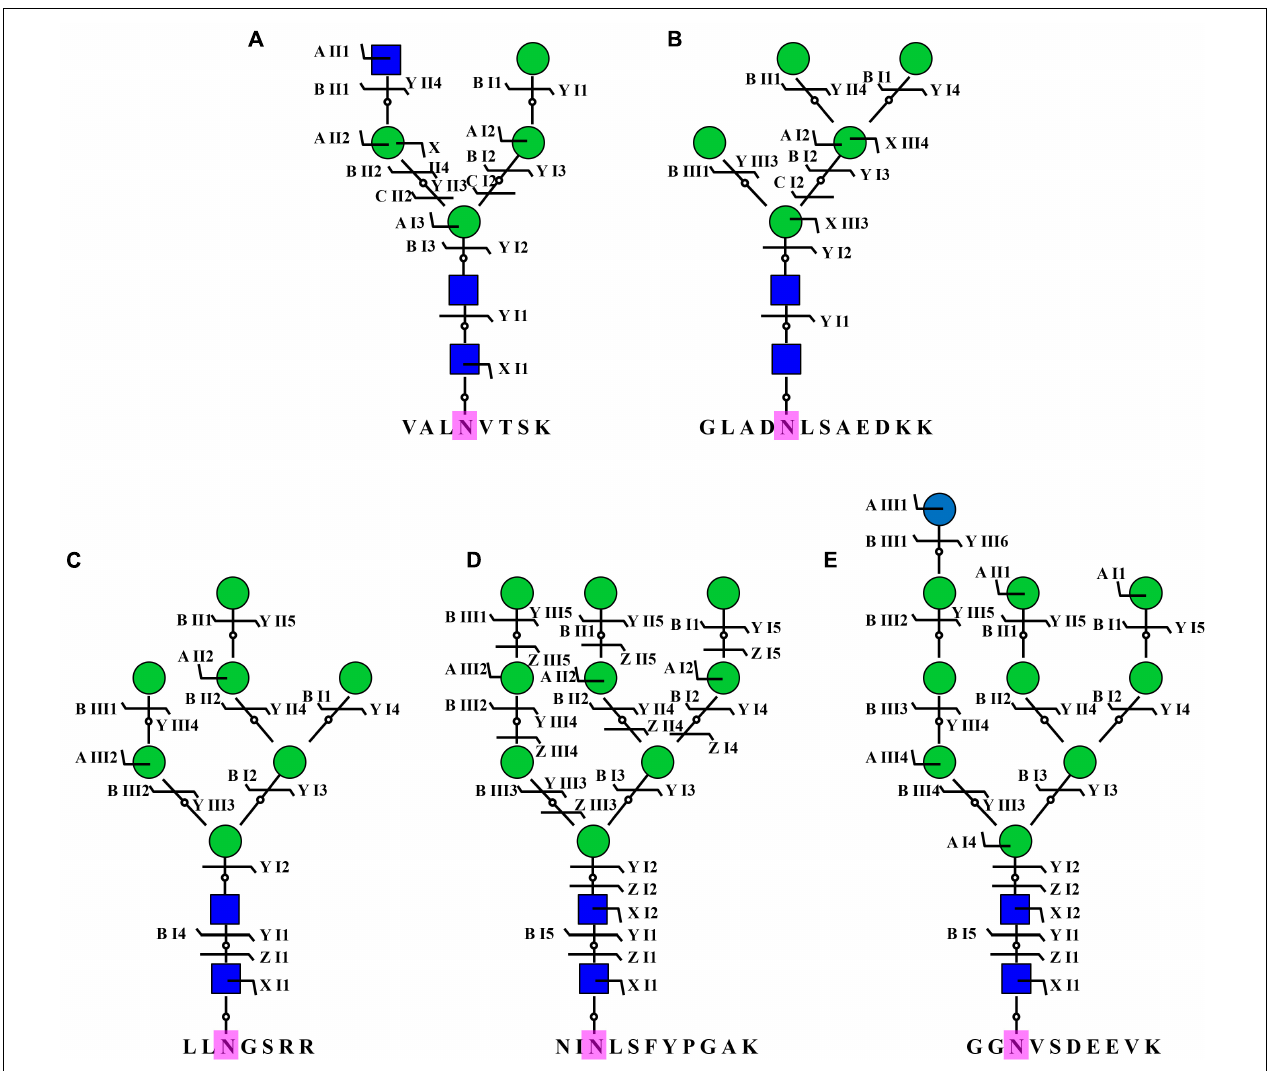
FIGURE 8 | Representative N-glycans identified in P. tricornutum. Five representative N-glycans were from five different N-glycoproteins, including B7FVG6 (A) , B7FUB7 (B) , B7FUL9 (C) , B7FUW2 (D) , and B7FTM0 (E) . Blue square is N-acetylglucosamine. Green circle is mannose. Blue circle is glucose. Purple N is asparagine amino acid for the